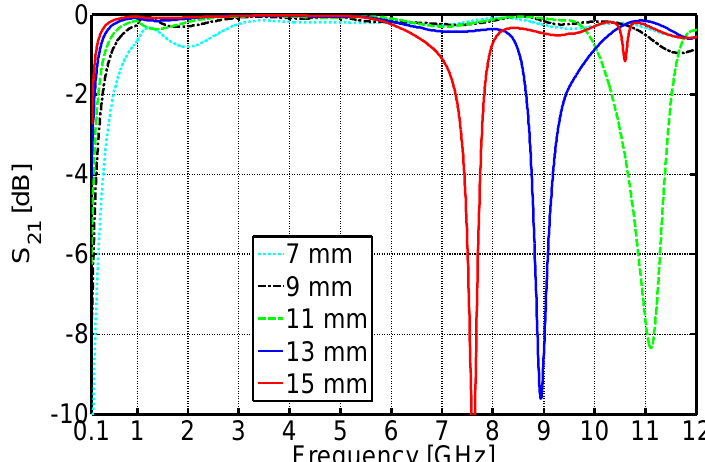
Figure 4. Gap transmission characteristics depending on the flange radius R’ (gaps filled with polyethylene).